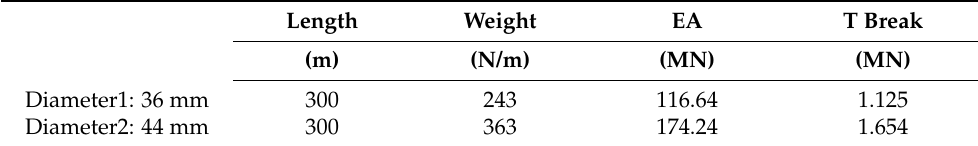
Figure 9. Configuration of the mooring system. Table 4. Material property of cables for Case 1.